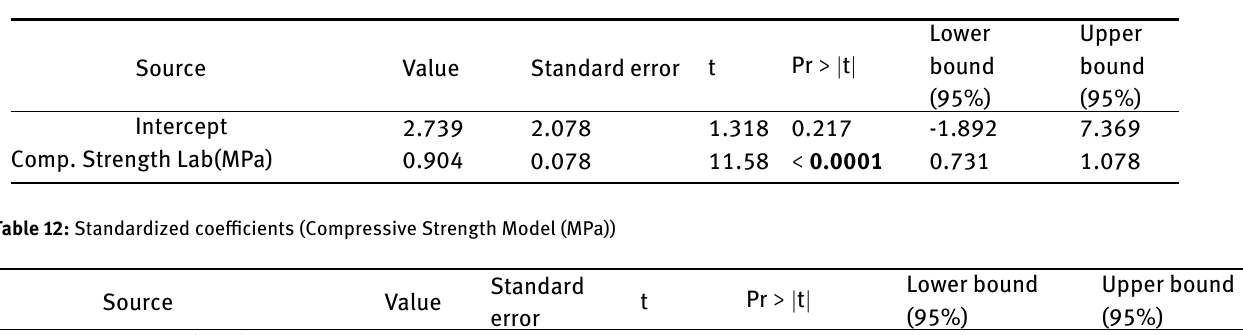
Table 11: Model parameters (Compressive Strength Model (Mpa))